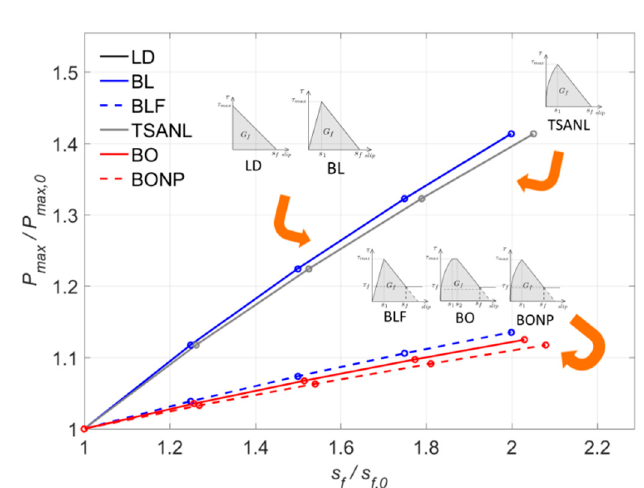
Figure 19. Variation of P max versus s f .